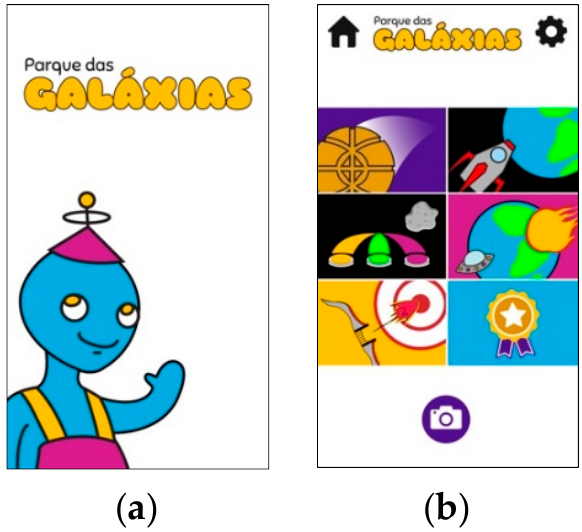
Figure 1. Game screens from the paper prototype: ( a ) launch screen; ( b ) home screen.